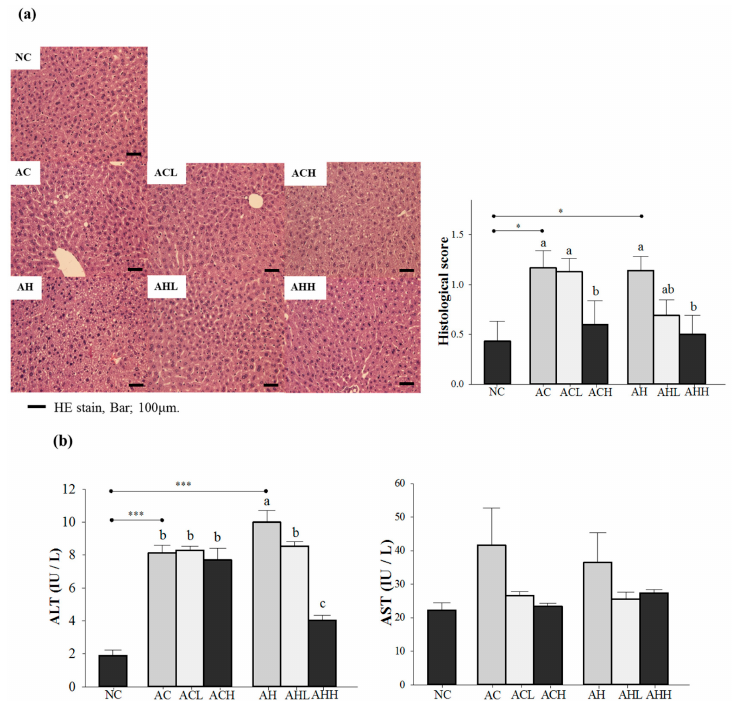
Figure 1. Effects of AK on hepatic damage in C57BL/6J mice fed with alcohol and HFD: ( a ) histopathological findings (hematoxylin-eosin staining) and ( b ) serum ALT and AST levels. Each value is expressed as the mean ± S.E. NC, normal control; AC, alcohol control; ACL, low-dose (1%) AK in alcohol group; ACH, high dose (3%) AK in alcohol group; AHC, alcohol/HFD control; AHL, low-dose AK in alcohol/HFD group; and AHH, high-dose AK in alcohol/HFD group. AK, ethanolic extract of Acanthopanax koreanum Nakai; HFD, high-fat diet; ALT, alanine aminotransferase; AST, aspartate aminotransferase. Mean bars with different alphabets are significantly different among alcohol ingestion groups at p < 0.05 with Duncan’s multiple comparison tests. * p < 0.05 and *** p < 0.0001 (AC and AH to NC).